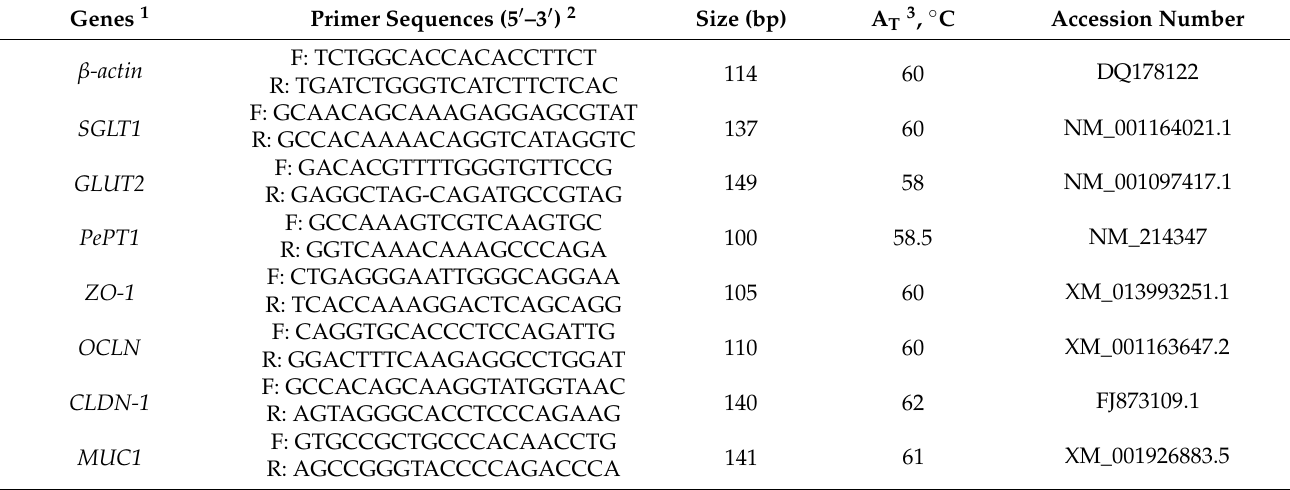
Table 2. Sequence of primers used for the real-time quantitative PCR analysis 1